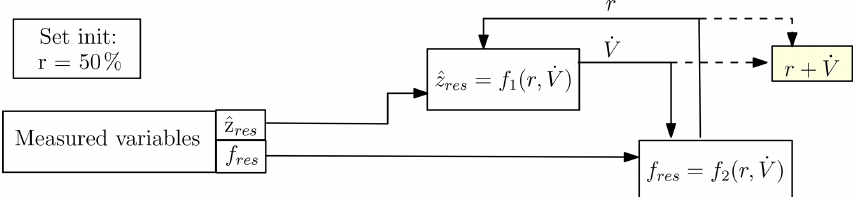
Figure 7. Model for the description of the iterative solution for the determination of the gas concentration in the gas mixture and the volume flow. The term “init” is short for “initialisation”.